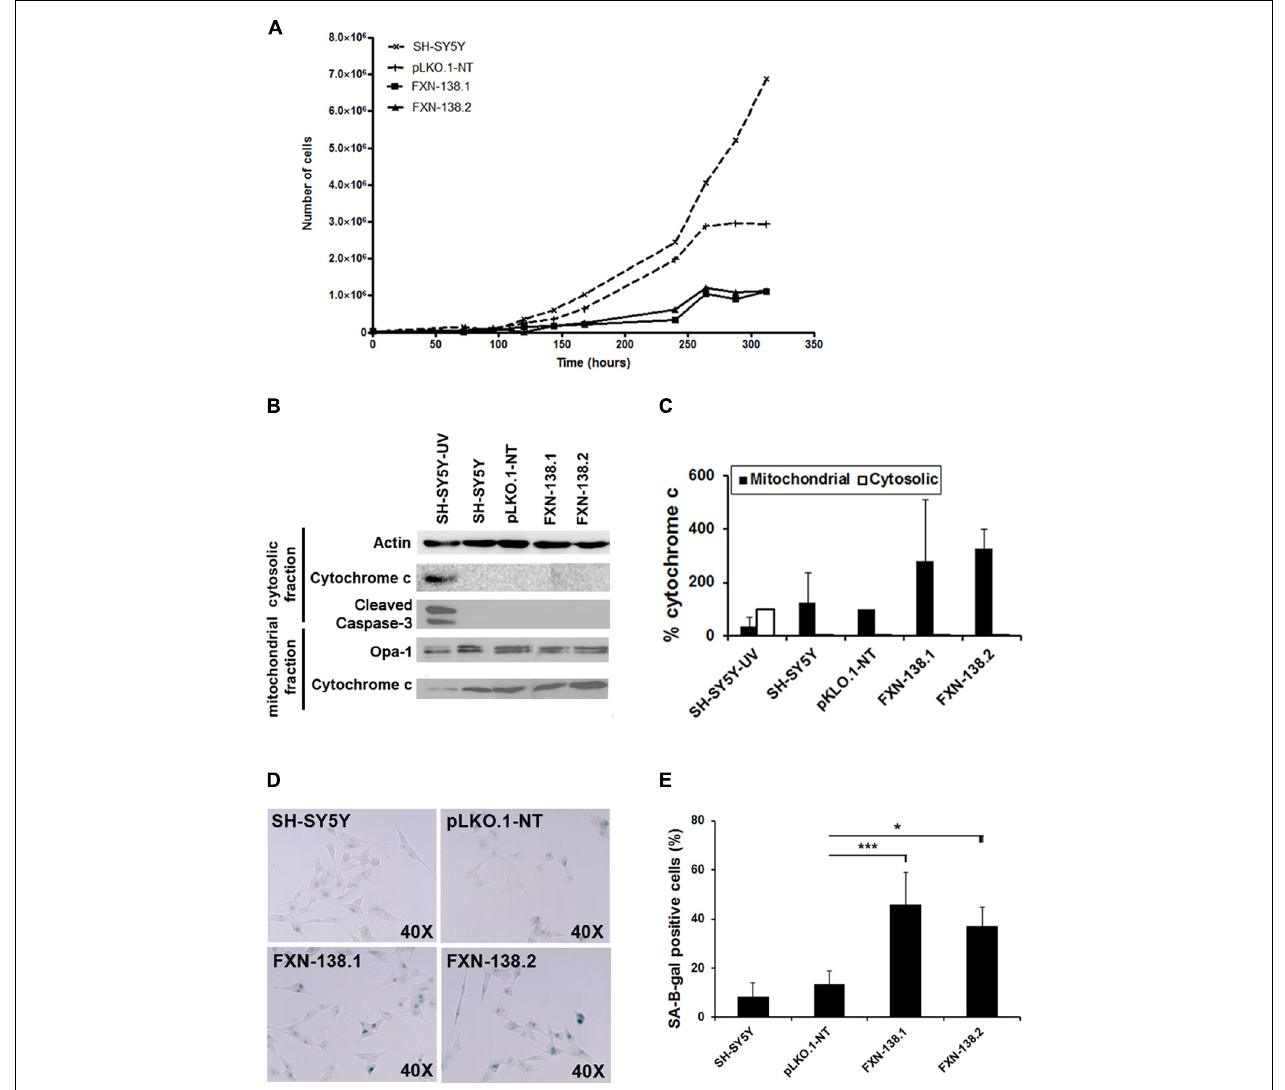
quantitative Western blot assay was developed to measure total cytochrome c in the mitochondria and cytosol. Data from cytosolic cytochrome c are expressed as percentage relative to apoptotic control, whereas data from mitochondrial cytochrome c are expressed as percentage relative to pLKO.1-NT control. (D) The clones indicated in the pictures were subjected to in situ SA- β -gal staining (blue) and examined by bright field microscopy. ( E) The figure represents the expression level of the lysosomal enzyme β -galactosidase in all lines. The columns and bar show the mean and standard deviation of no fewer than 1300 cells from at least three experiments. Student’s t -test, FXN-138.1 p = 0.001, FXN-138.2 p = 0.02 versus pLKO.1-NT. *p ≤ 0.05; *** p ≤ 0.001.